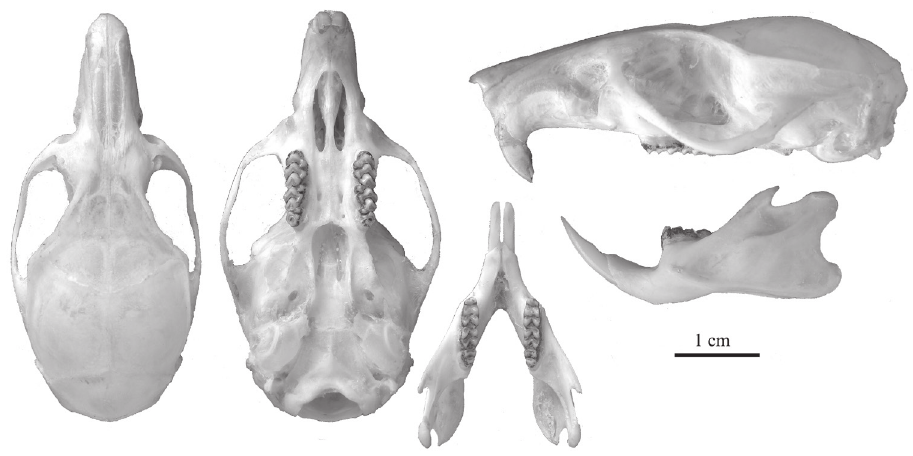
Figure 8. The holotype of Chiromyscus thomasi sp. n., Son La Province, northern Vietnam, skull ZMMU S-191982, genetic voucher